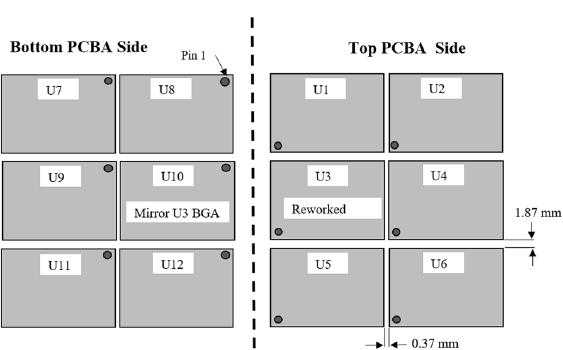
Figure 7. Schematic of BGA components position and reworked component location (U3).